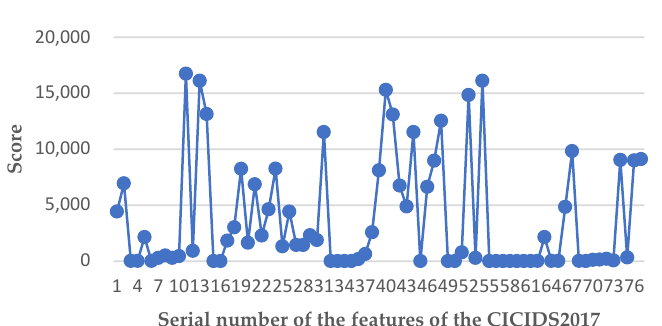
Figure 3. The score of each feature in the NSL-KDD, UNSW-NB15 and CICIDS2017 datasets. The proposed model is trained based on different numbers of features. After the training, the appropriate ensemble weights were obtained. Finally, different numbers of features (2, 3, 5, 10, 15, 20, . . . ) were fed into the proposed method, and the three classification accuracy curves were obtained, as shown in Figure 4. The orange curve, blue curve and green curve represent the test accuracy based on NSL-KDD, NUSW-NB15 and CICIDS2017 datasets, respectively. The change trends of the three accuracy curves are similar. As the number of selected features increases, the testing accuracy increases rapidly at the beginning, and finally shows a stable trend. It is observed that the maximum accuracy is achieved when the number of features is about 20, 19 and 25 in the three datasets.